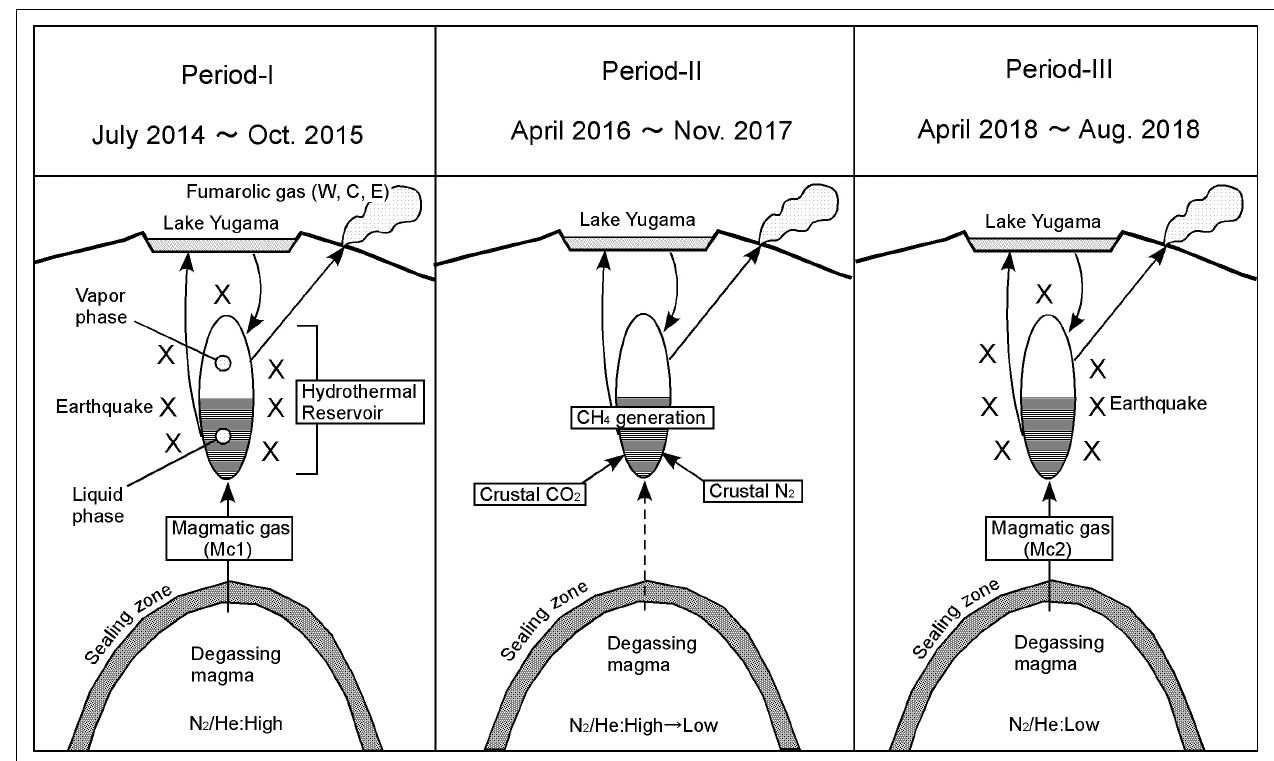
FIGURE 10 | Conceptual model for the evolution of magma hydrothermal system beneath Crater lake